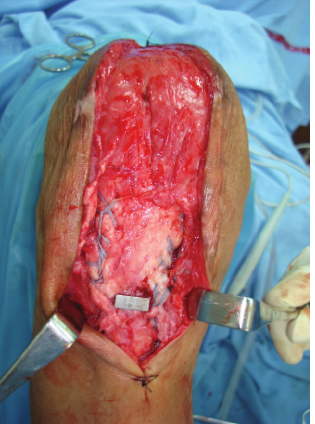
Figure 6: Showing repair being supplemented with staple.